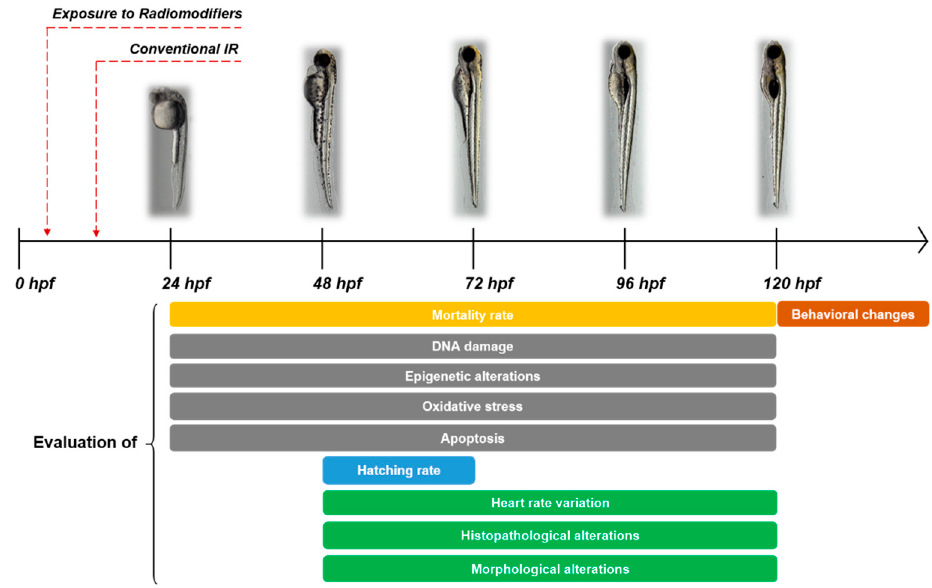
Figure 1. Diagrammatic representation of the experimental assays employed in the studies described in this review.